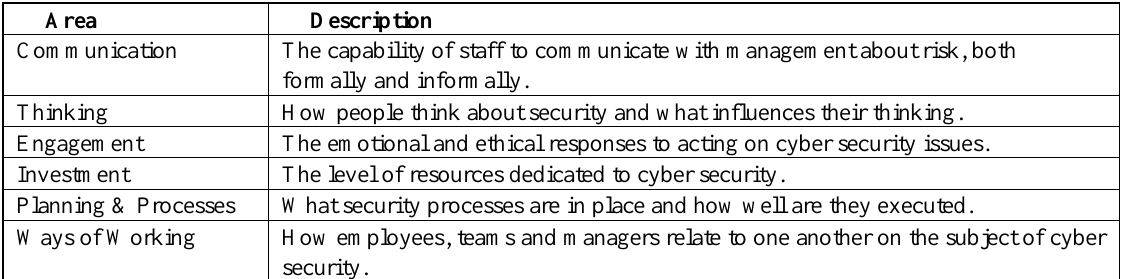
Table 1. Areas of